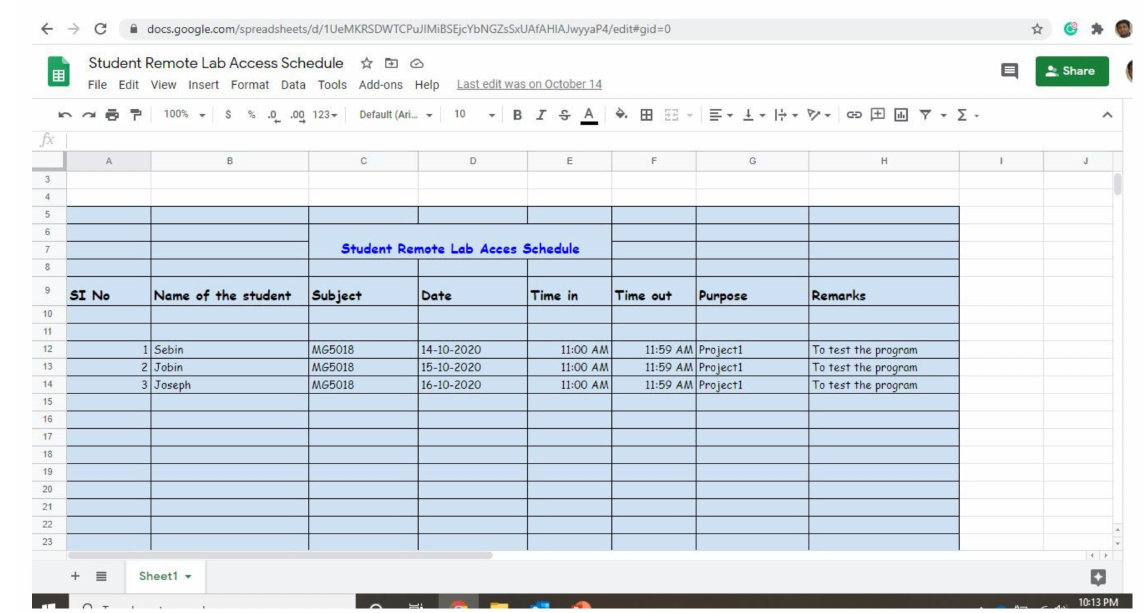
Figure 6. Sample of remote lab access